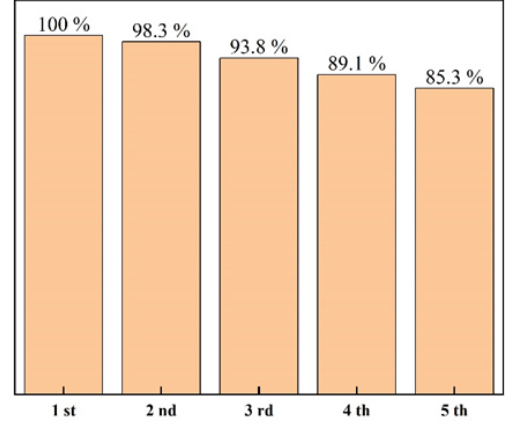
Figure 11. The stability tests for Cu/BVO photocatalysts.